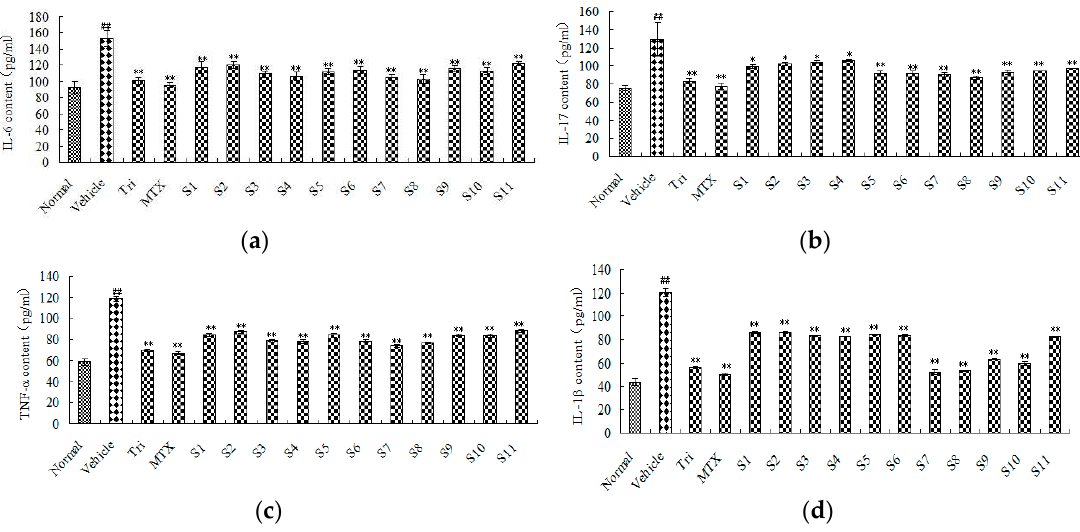
Figure 4. The levels of pro-inflammatory cytokines: ( a ) TNF- α content; ( b ) IL-1 β content; ( c ) IL-6 content; and ( d ) IL-17 content. ## : p < 0.01 was significant difference between vehicle group and the control group; *: p < 0.05 was considered statistically significant between vehicle group and treatment groups; ** : p <0.01 was significant difference between vehicle group and treatment groups. Table 4. Multiple comparison SNK test results of TNF- α ( a :Alpha).